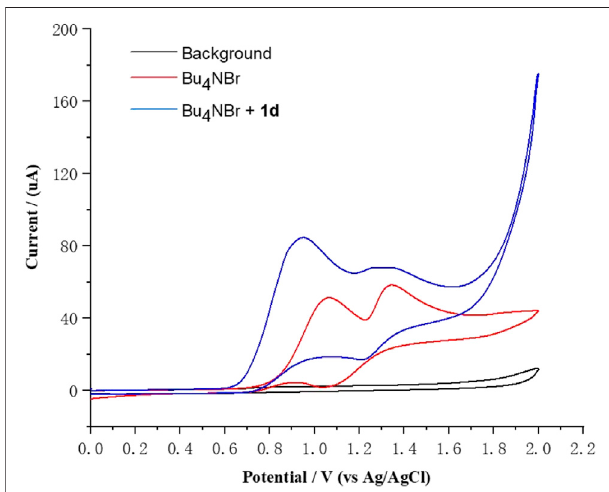
FIGURE 1 | Cyclic voltammetry measurements of Bu 4 NBr and 1d . Conditions: glassy carbon disk electrode (diameter is 3.0 mm, PTFE shroud) as the working electrode, platinum wire as the counter electrode, Ag/AgCl electrode (3.5 M KCl solution) as the reference electrode, Bu 4 NOTf (0.10 M in MeCN), under an argon atmosphere, cyclic voltammogram at 0.05 V s − 1 with Bu 4 NBr (5 mM) or Bu 4 NBr (5 mM) and 1d (5 mM).